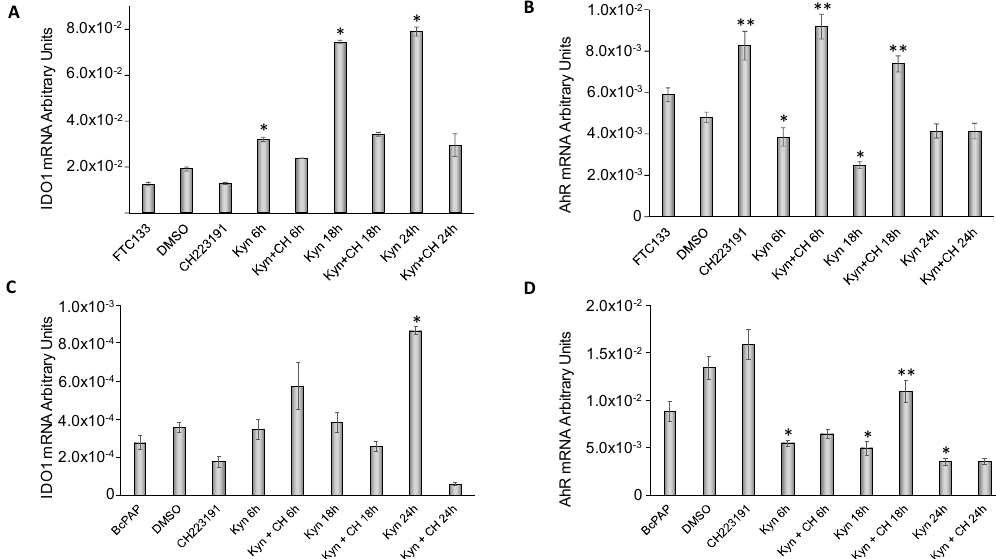
Figure 5. E ff ects of kynurenine on immune regulatory genes IDO1 and AhR. FTC-133 and BcPap cells were incubated for the indicated times with kynurenine (100 µ M) in the presence or absence of the AhR inhibitor CH223191 (10 µ M) and harvested for total RNA extraction and cDNA synthesis. IDO1 and AhR mRNA expression levels were assayed by qPCR. The data are presented as means of arbitrary units. All experiments were repeated three times and the more representative results are depicted. p values were calculated applying the unpaired Student’s t test. DMSO: Dimethyl sulfoxide treated cells; Kyn: kynurenine treated cells; CH: CH223191 treated cells. ( A ) IDO1 expression in FTC-133 cells; ( B ) AhR expression in FTC-133 cells; ( C ) IDO1 expression in BcPap cells; ( D ) AhR expression in BcPap cells. * Di ff erences between kynurenine-treated cells and untreated cells, p < 0.05. ** Di ff erences between cells treated with CH223191 alone or in combination with kynurenine and respective controls, p < 0.05.